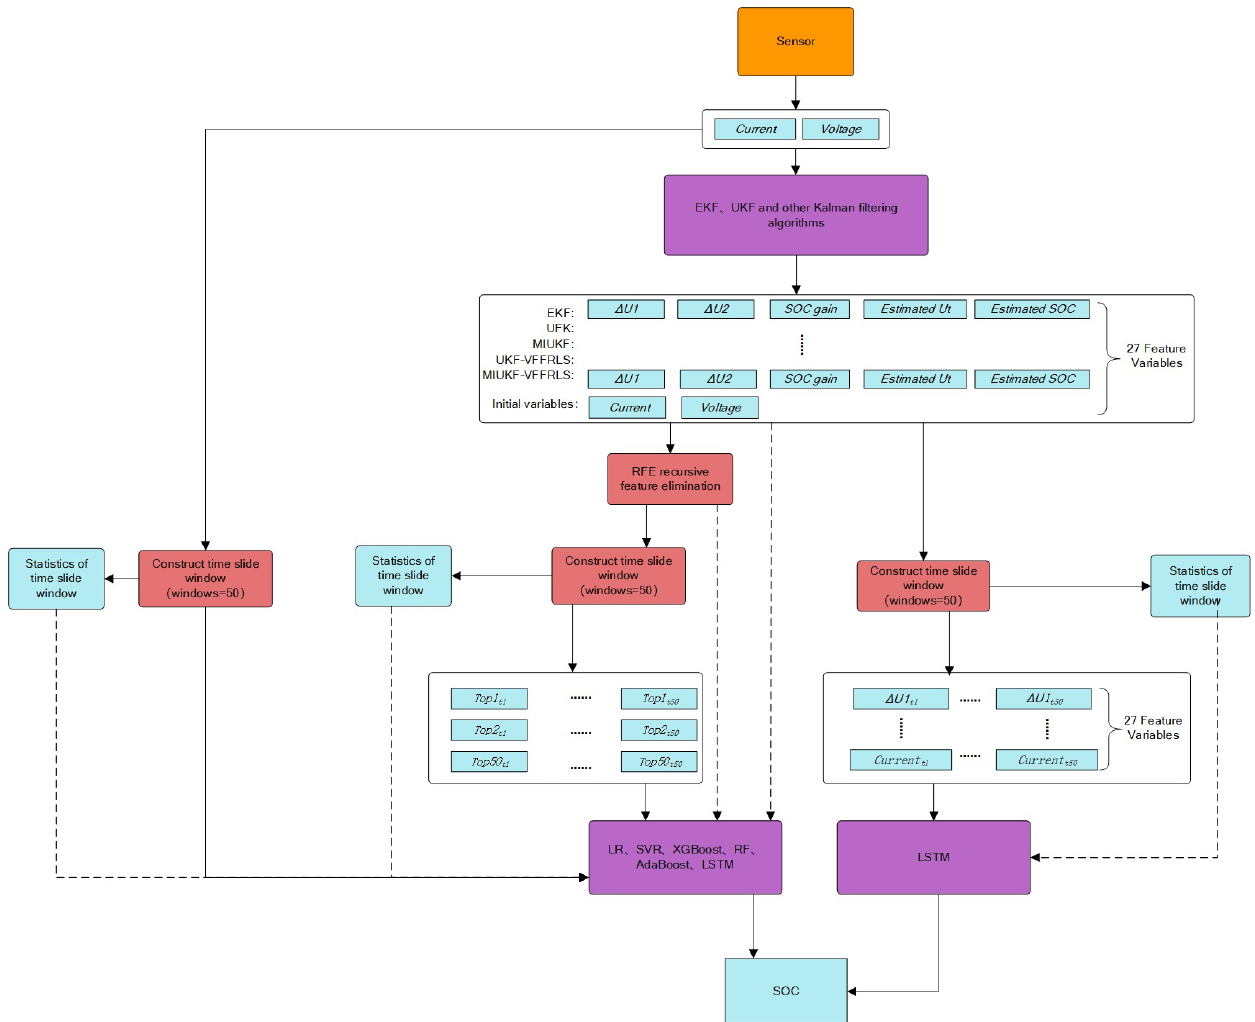
Figure 1. The overall block diagram of the algorithm .